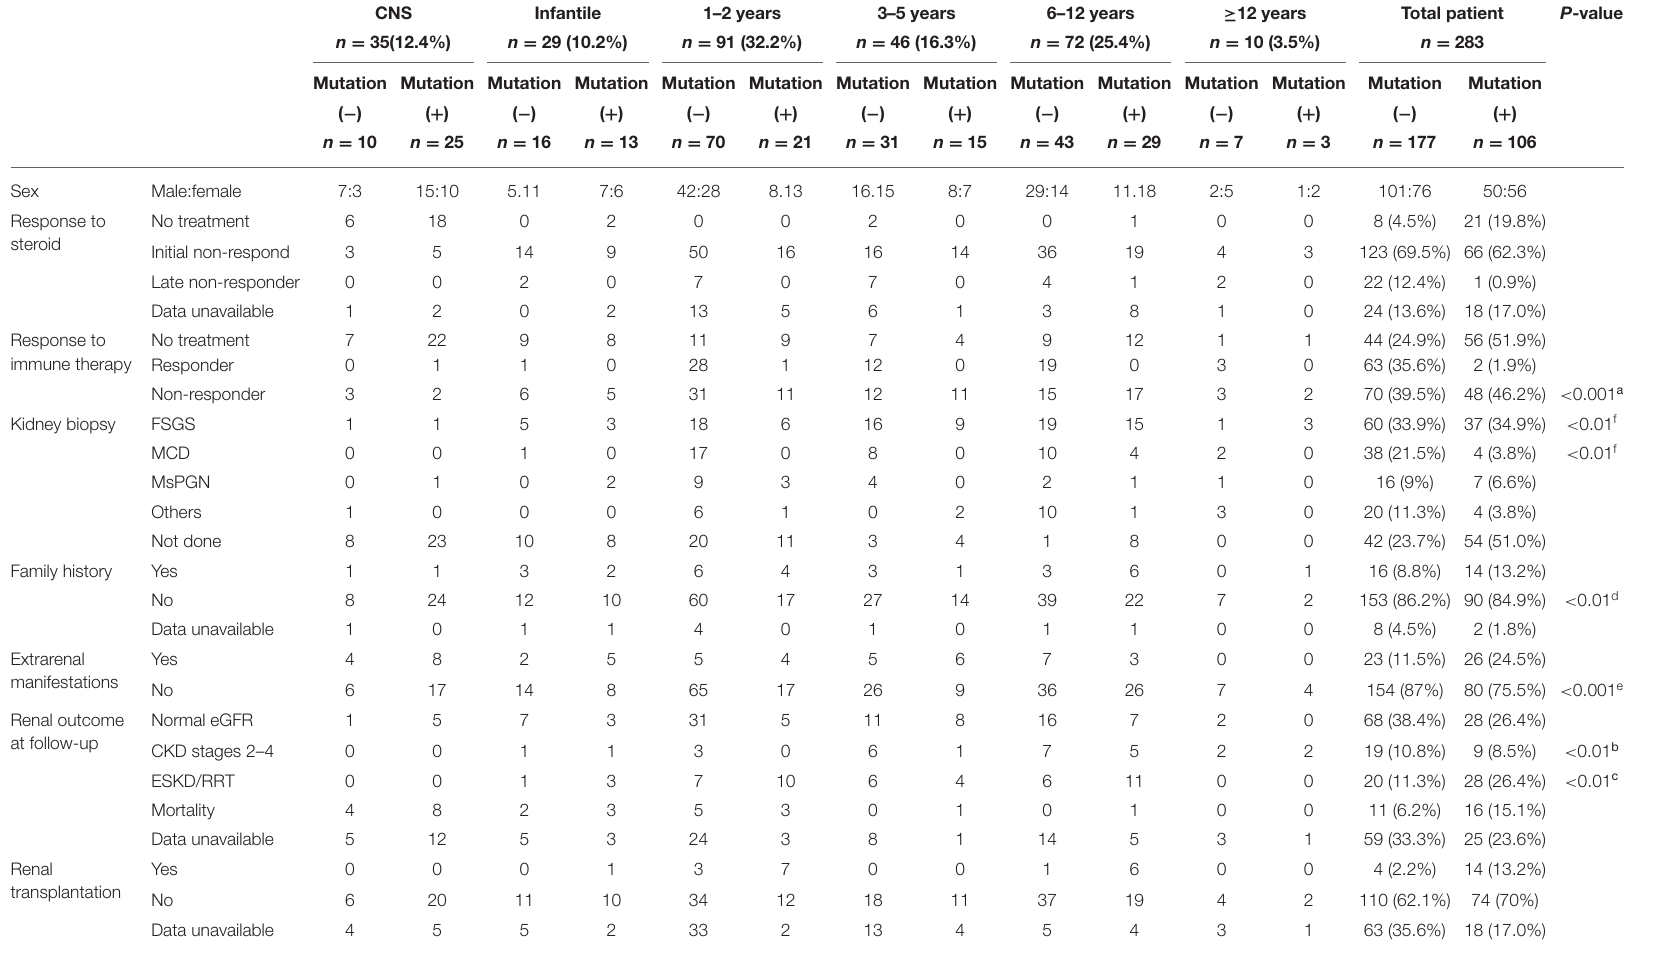
TABLE 1 | Genotype-phenotype correlations in pediatric patients with steroid-resistant nephrotic syndrome. CNS